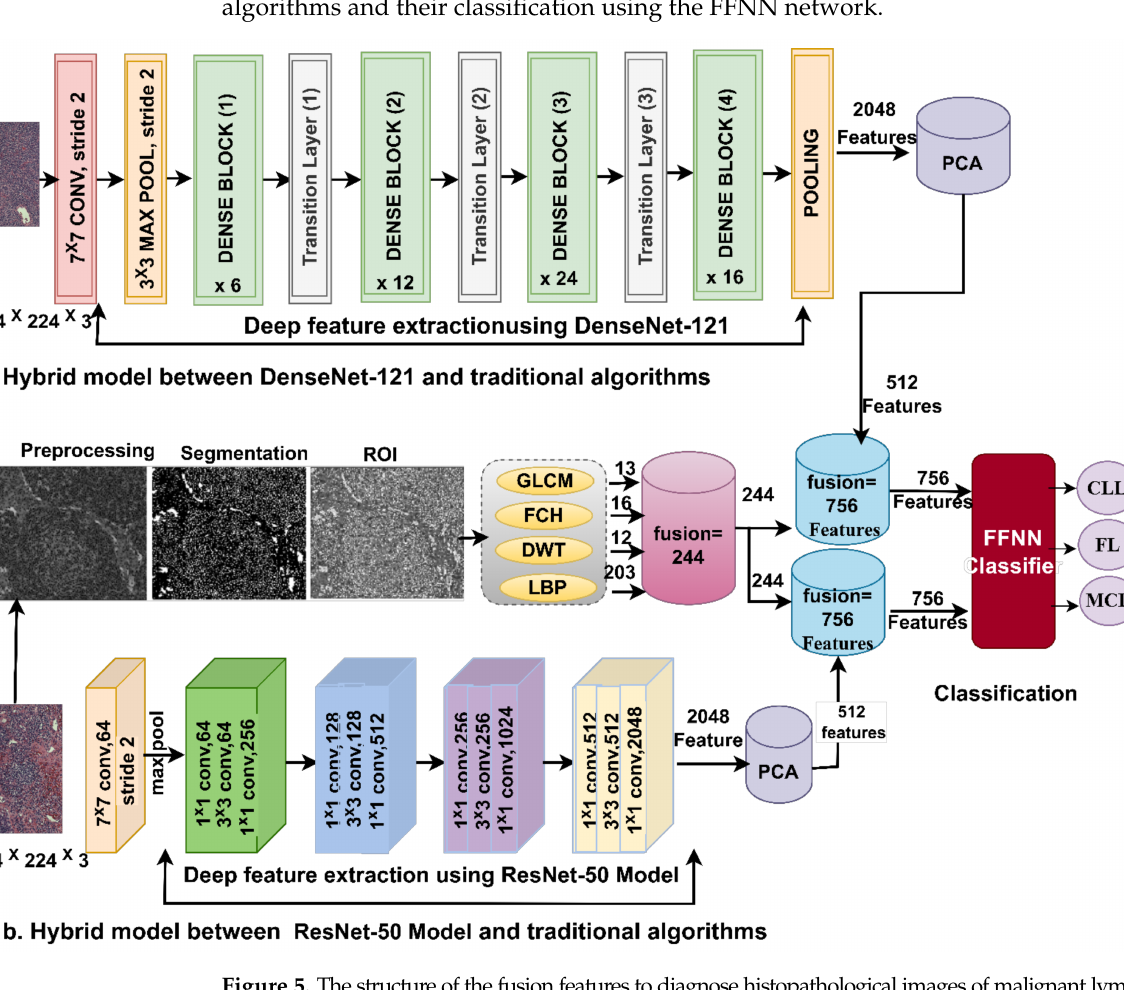
Figure 5. The structure of the fusion features to diagnose histopathological images of malignant